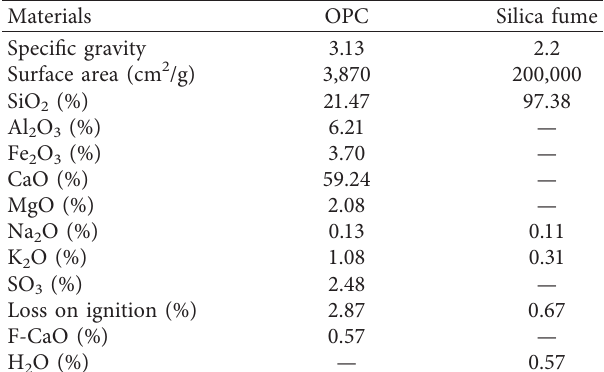
Table 1: Physical and chemical properties of cement and silica